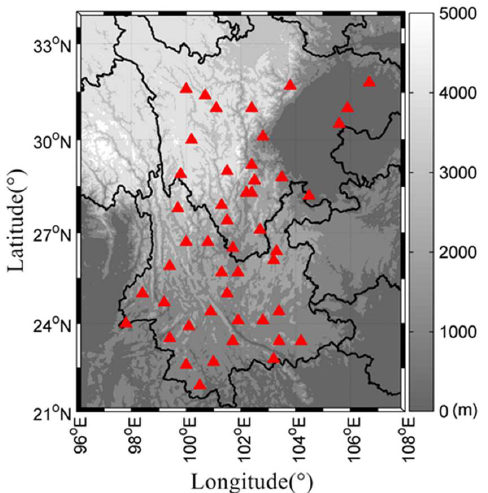
Figure 1. Study area map. The red triangles are the GPS sites use in the inversion calculation in the Sichuan-Yunnan region. The background colors show the surface topography.